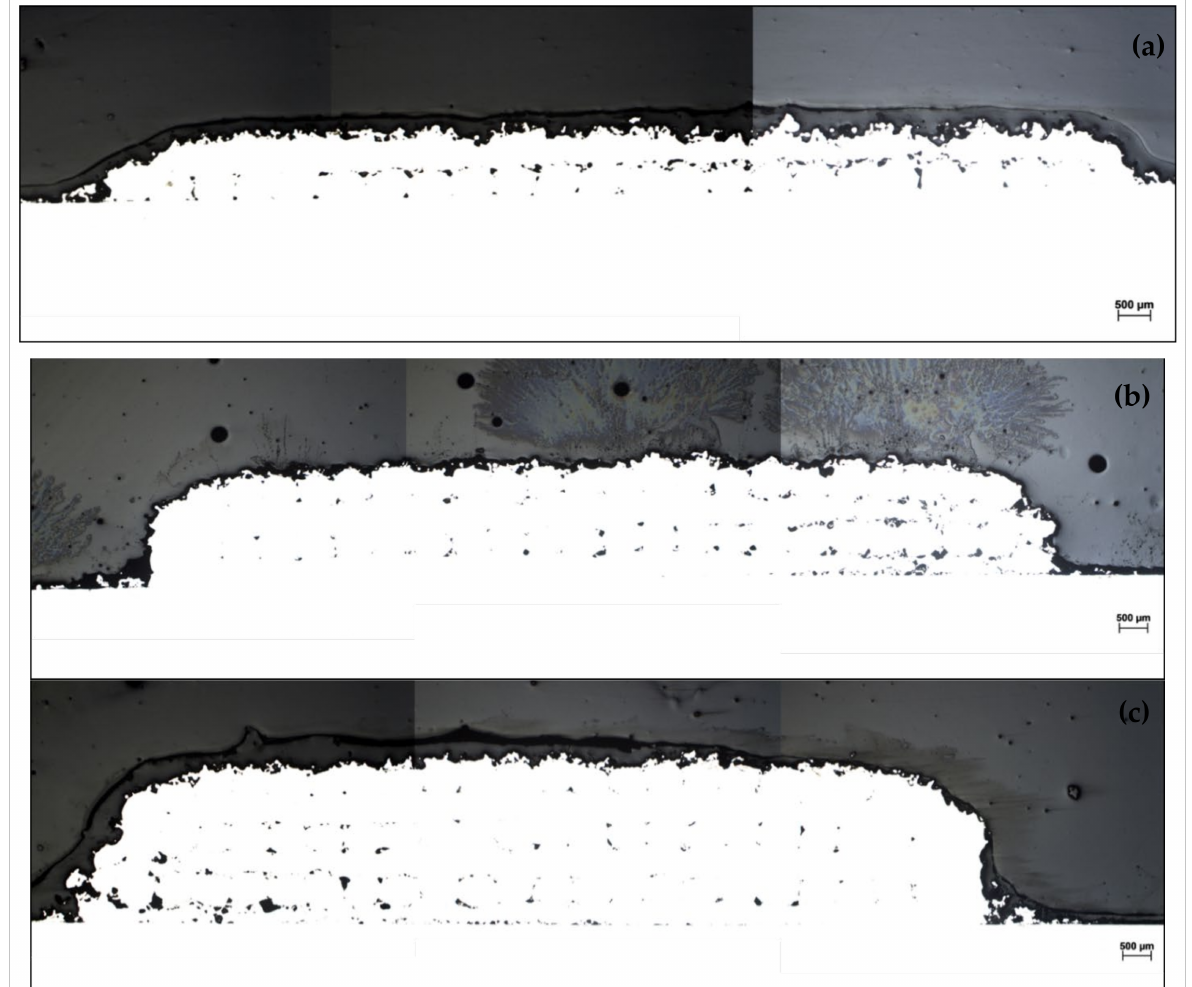
Figure 2. Porosity analysis of the layers deposited by LMD: ( a ) 2 layers, ( b ) 4 layers, ( c ) 6